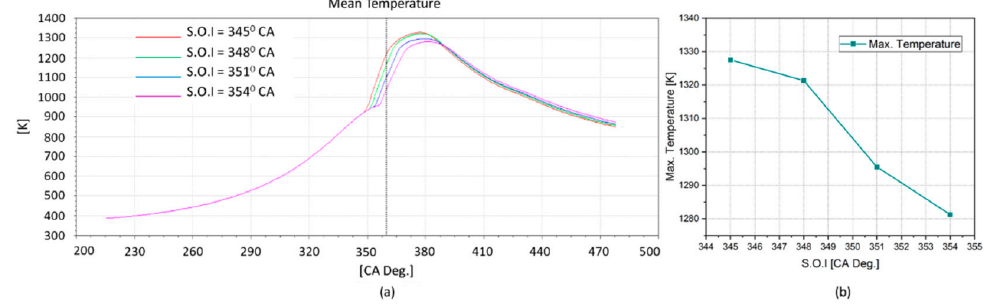
Figure 22. In-cylinder temperature diagrams ( a ) and maximum temperature ( b ) according to the change of the pilot S.O.I angle in the dual-fuel